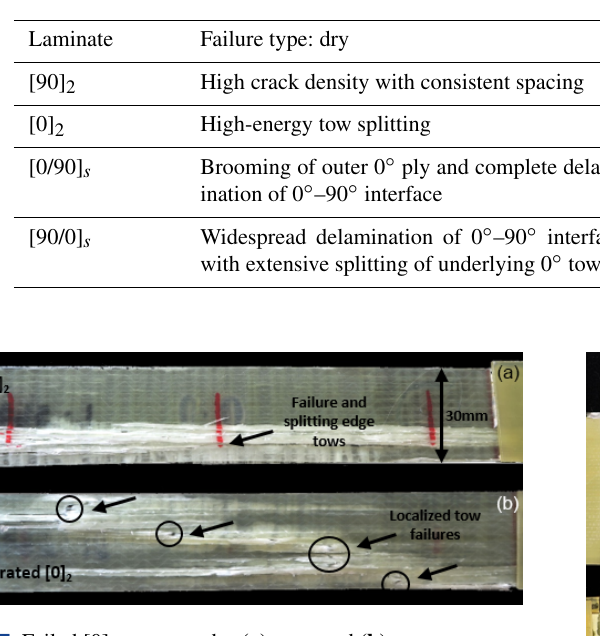
Figure 7. Failed [0] 2 coupons dry (a) saturated (b) .